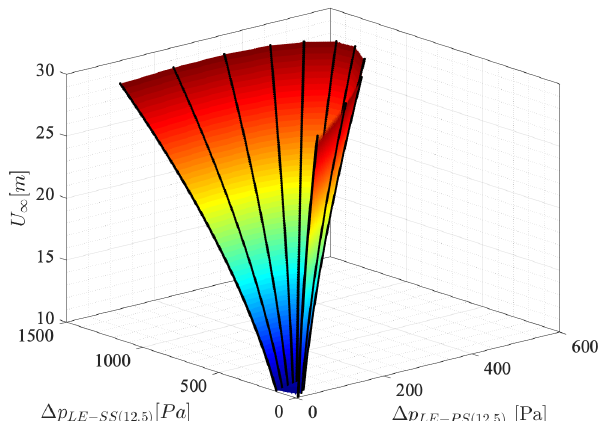
Figure C1. Calibration function for estimating the inflow velocity. Example shows the result for a flap angle of β = 0 ◦